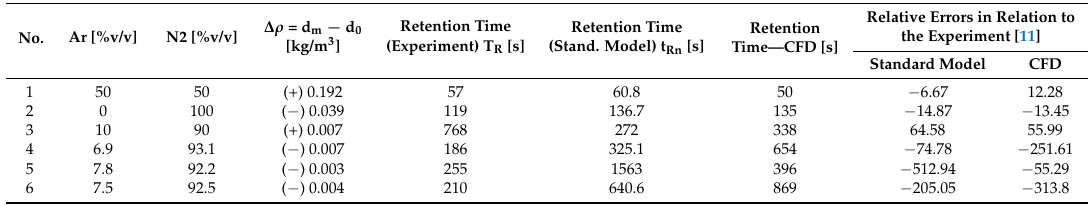
Table 2. Retention times of fire-extinguishing